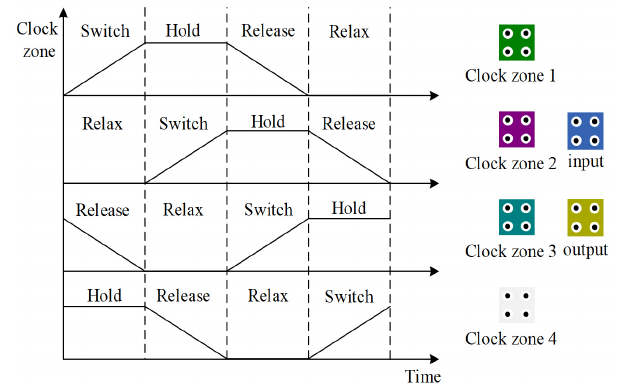
Figure 2. QCA clock. Figure 2. QCA